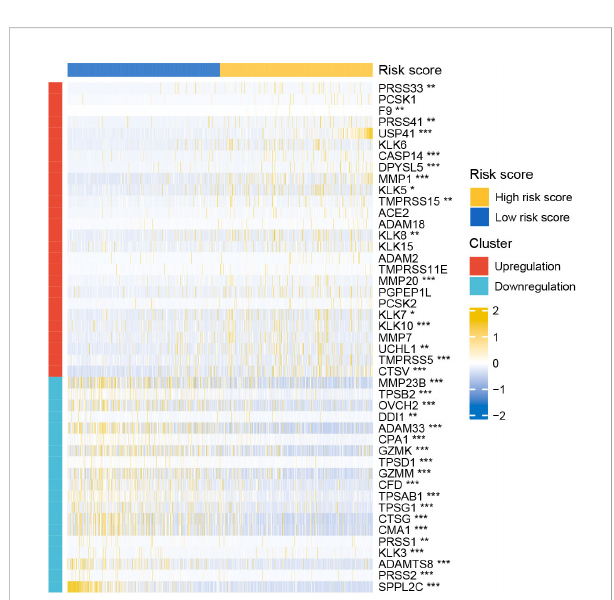
FIGURE 7 Expression pattern of DRGs between the low- and high-risk